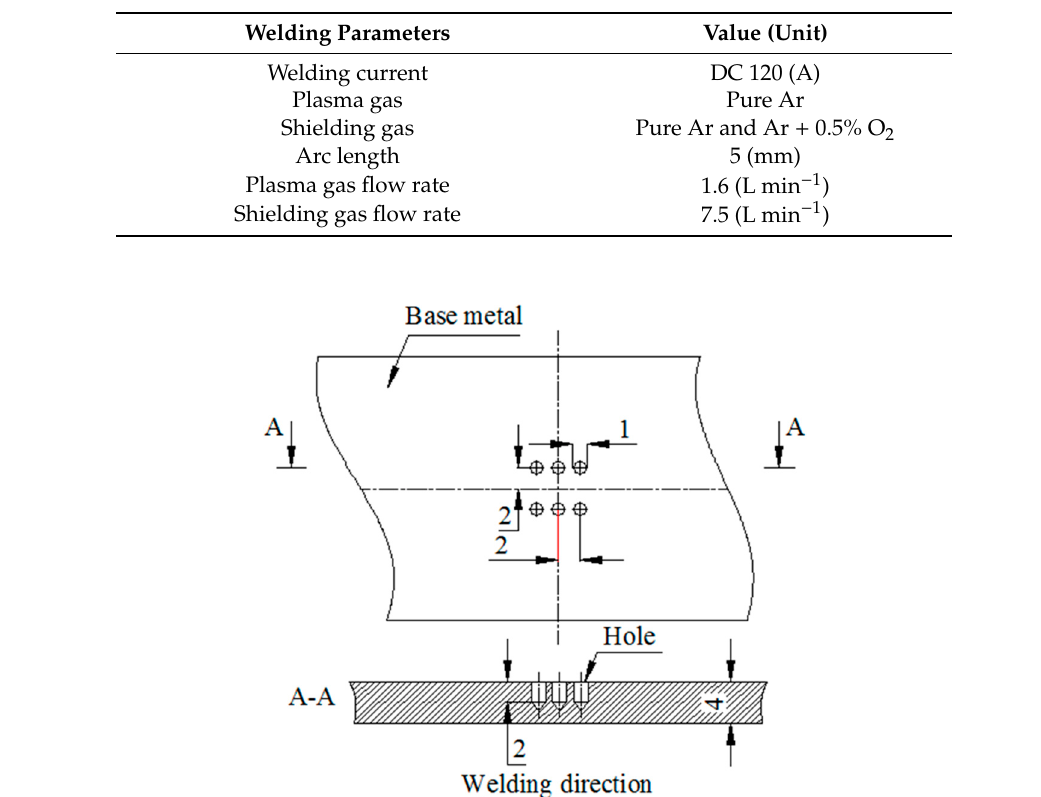
Table 2. Welding conditions.